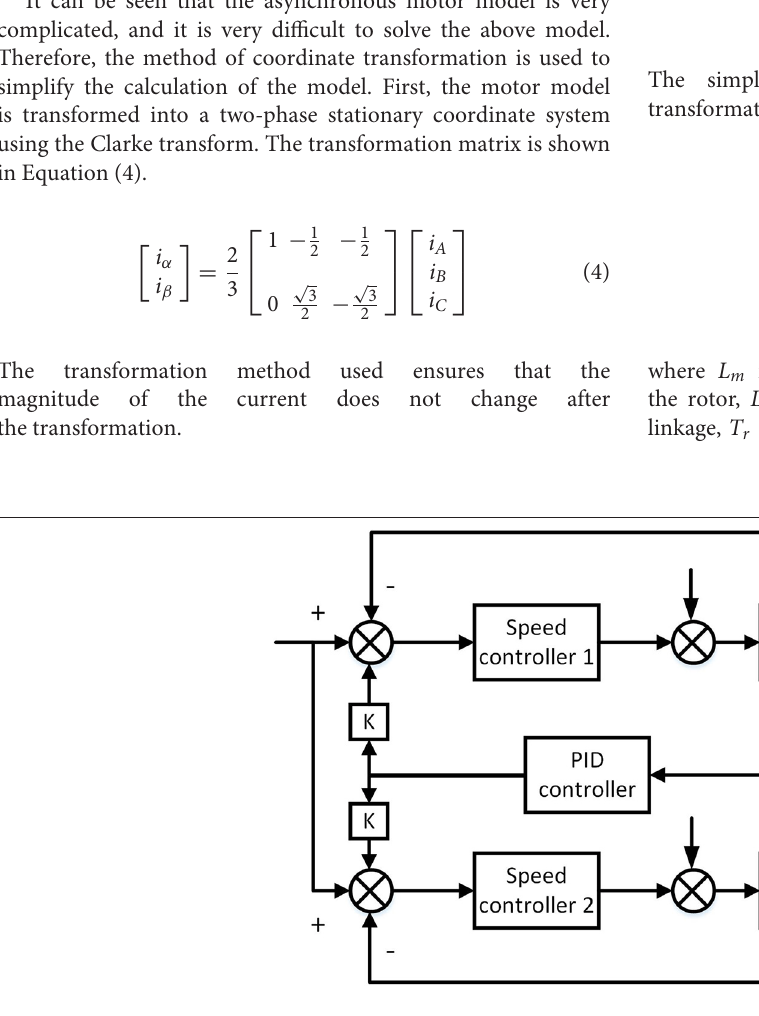
FIGURE 12 | Control strategy for multiple motors.